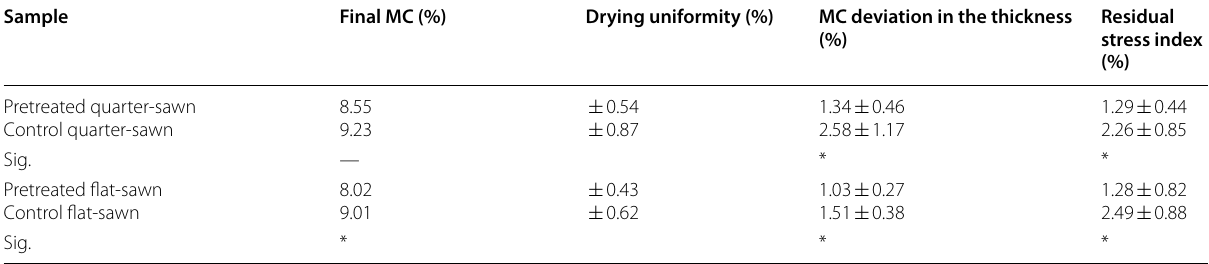
Values of drying uniformity are standard deviations of the final MC. * Means significant at 0.05 level, — Means not significant at 0.05 level